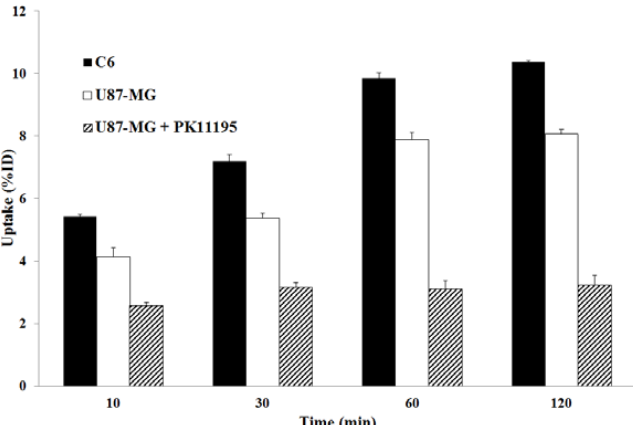
Figure 3. Uptake kinetic of 99m Tc-CB256 ( 1 ) into C6 and U87-MG cells in the presence or absence of PK 11195. Data are expressed as percentage injected dose (% ID, mean with S.D. n = 4). Closed bar: uptake of 1 in C6 cells; open bar: uptake of 1 in U87-MG cells; right-handed striped bar: uptake of 1 in U87-MG cells in the presence of 300 µM PK 11195.